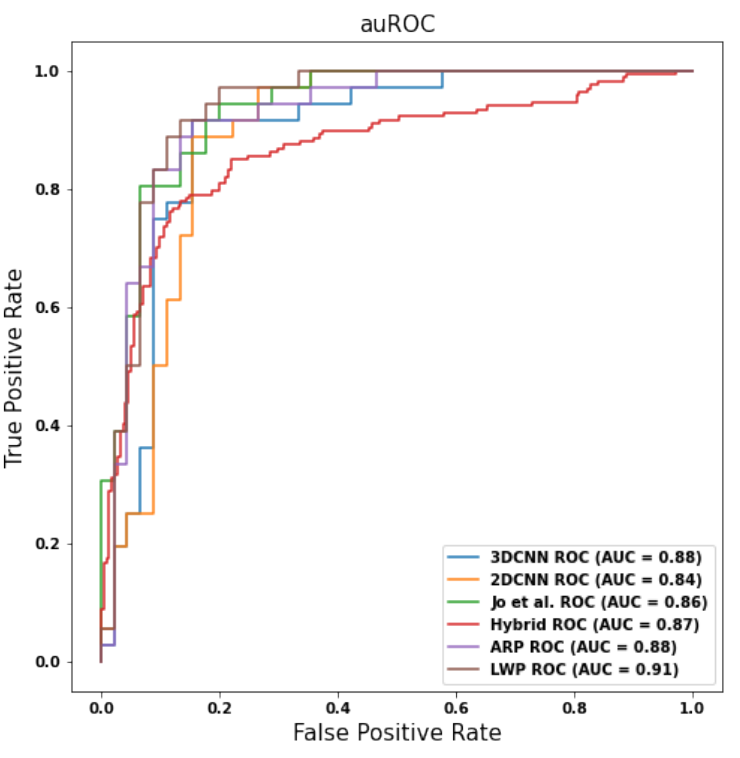
Figure 5. The ROC curves of the different models.